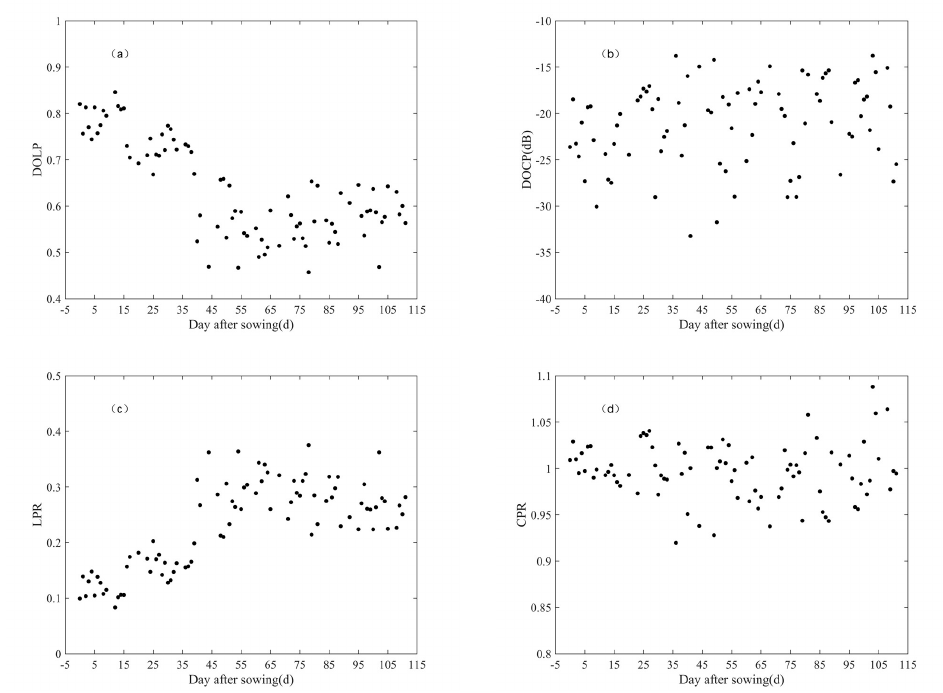
Figure 9. The Group 2 olp D , ocp D , pr L and Cpr on the evolution of rapeseed phenology .